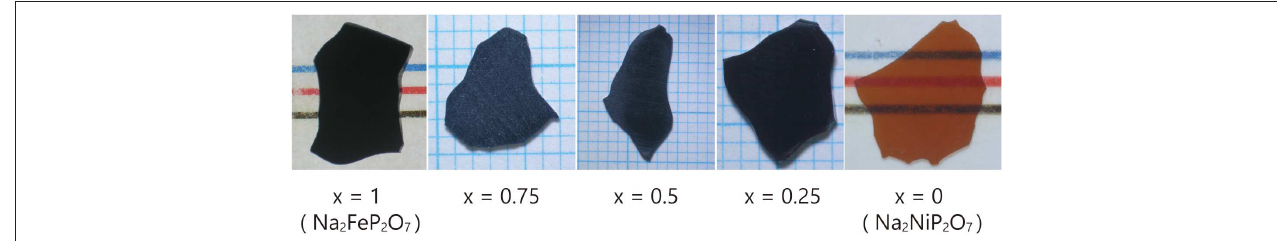
FIGURE 1 | Appearance of the fabricated Na 2 Fe x Ni 1 − x P 2 O 7